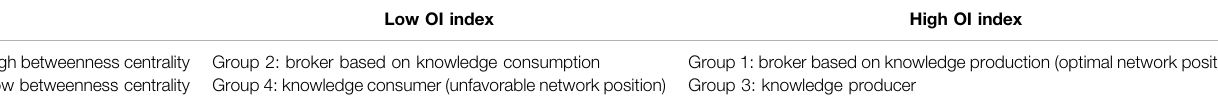
TABLE 7 | Division of province position according to OI index and betweenness